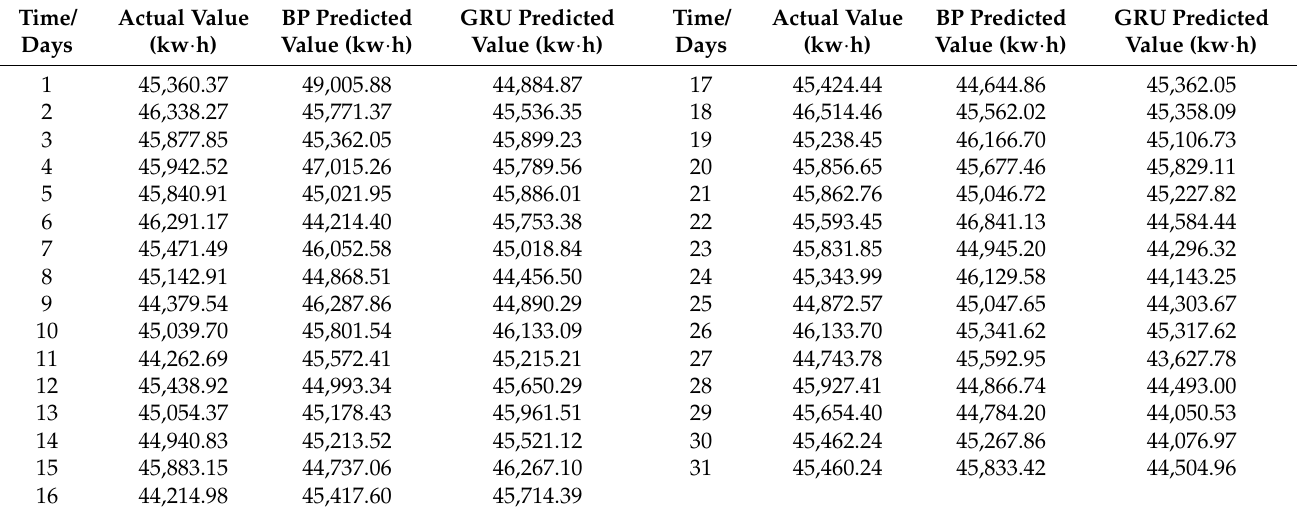
Figure 5. Normalized load data.